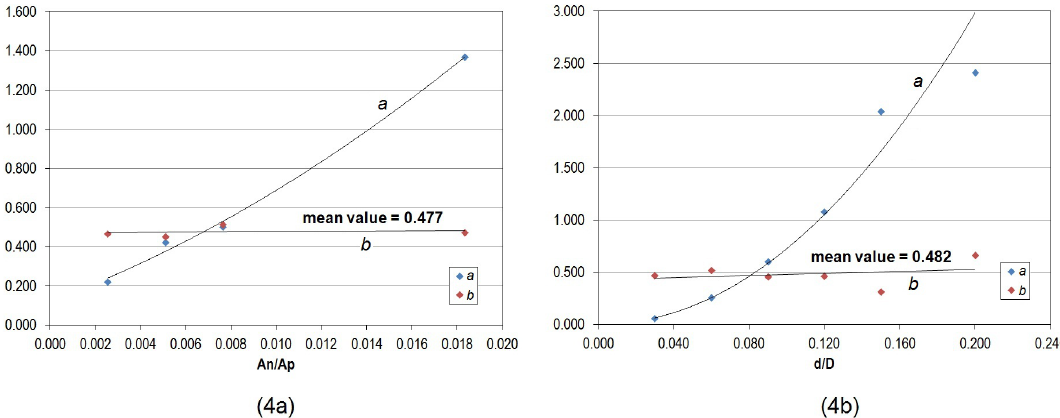
Figure 4. Discharge coe ffi cients according to: (a) A n / A p ratio (rectangular nozzles); (b) d / D ratio (round nozzles). Dynamic tests on steel pipe.